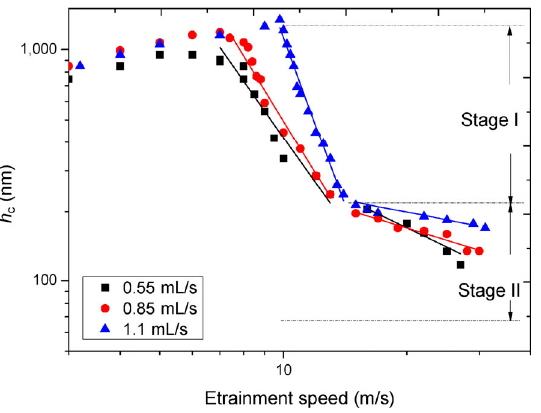
Fig. 4 Measurements of starved film thickness for three different